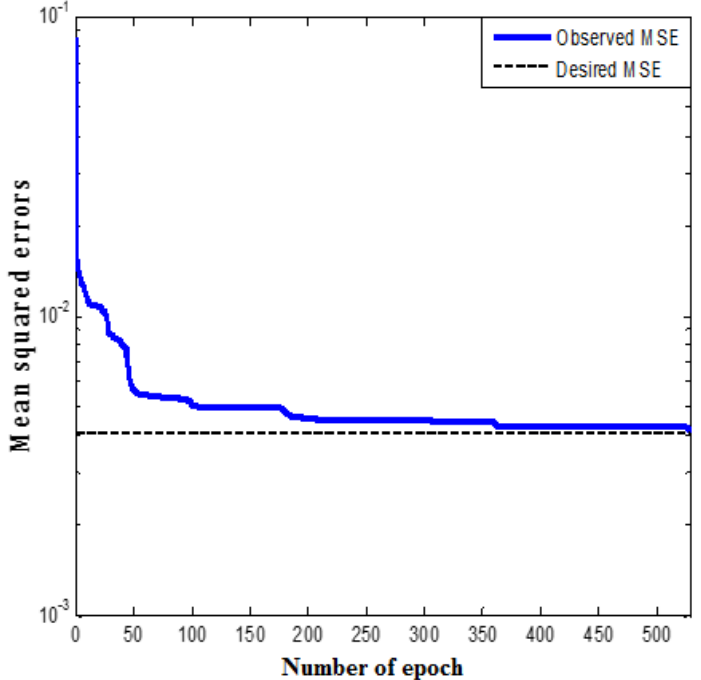
Figure 4. The MSE for the multi-layer perceptron (MLP) network with 1 to 4 hidden neurons (50 networks per neuron) during the training stage.